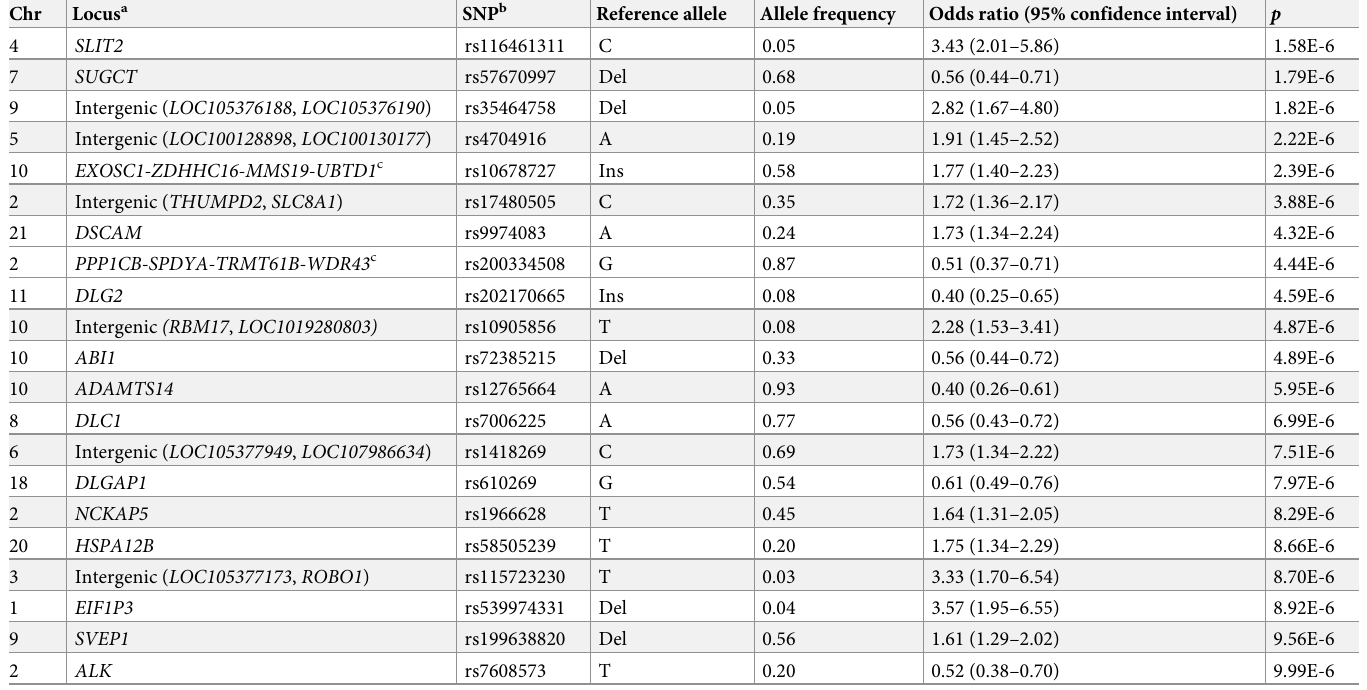
Table 1. Single-nucleotide polymorphisms suggestively associated with spontaneous preterm birth.